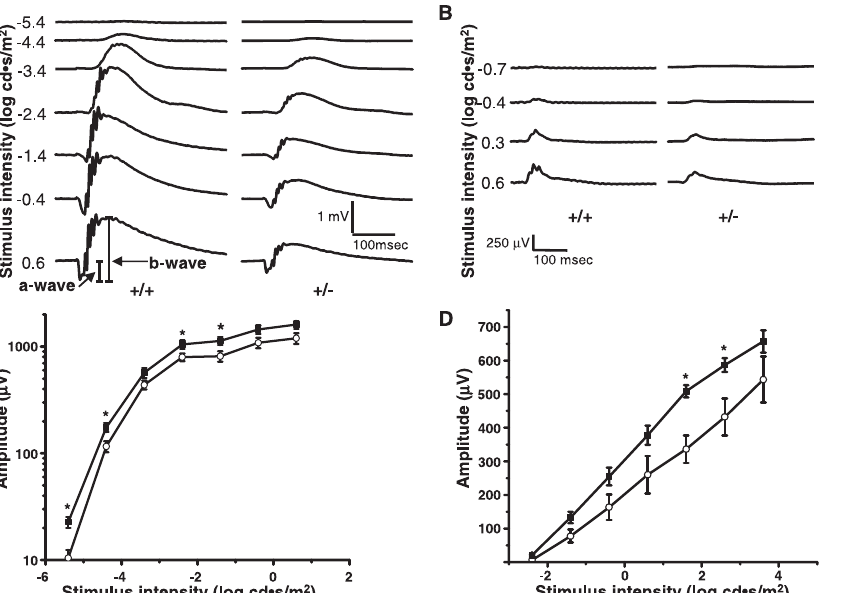
Figure 8. Electroretinograms from 6-Mo-Old RanBP2 þ / (cid:1) and RanBP2 þ / þ Inbred Mice Showing Photoreceptor and Postreceptor Neuron Electro- physiological Response Phenotypes (A) Scotopic (dark-adapted) responses from RanBP2 þ / (cid:1) mice to light stimuli of increasing intensity, beginning at threshold, have reduced amplitudes compared to those observed in RanBP2 þ / þ mice. The three lower intensities represent responses generated in the rod photoreceptor neuronal pathway. The upper intensities are comprised of responses generated in both the rod and cone pathways. (B) Photopic (light-adapted, cone photoreceptor pathway) responses of RanBP2 þ / (cid:1) mice to increasing light stimulus intensities also exhibited reduced amplitudes compared to those observed in RanBP2 þ / þ mice. (C) Average 6 SE ( n ¼ 9) scotopic b -wave amplitudes from RanBP2 þ / (cid:1) (open circles) and RanBP2 þ / þ (filled squares) mice representing postreceptoral neuron function. (Note: log amplitude scale.) (D) Average 6 SE ( n ¼ 5) scotopic a -wave amplitudes, representing photoreceptor function, for RanBP2 þ / (cid:1) and RanBP2 þ / þ mice in response to bright flashes. Amplitudes of responses from RanBP2 þ / (cid:1) mice were lower over the entire range of stimulus intensities for both b - and a -waves. Asterisks represent significant differences between the groups (Student’s t test, p , 0.05). Statistical significance was found across all intensities for b -wave amplitudes (2-way ANOVA, p , 0.0001), but not for the a -wave. DOI: 10.1371/journal.pgen.0020177.g008